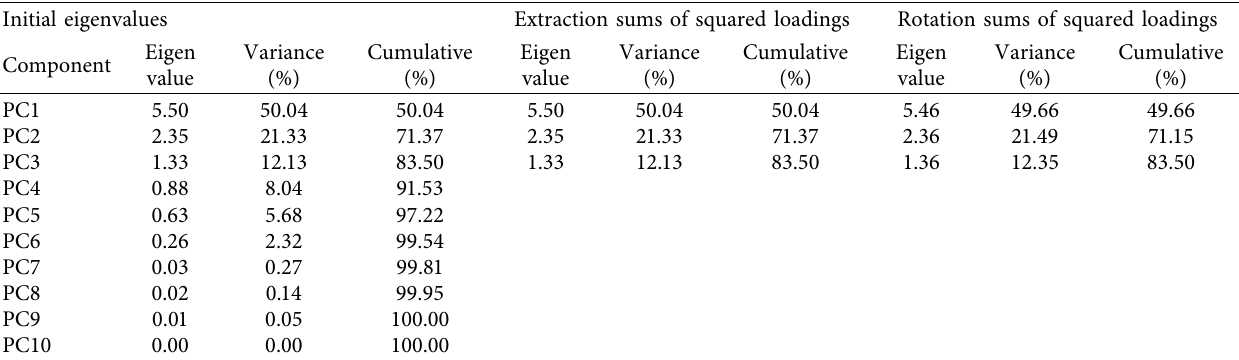
Table 6: Total variance explained (three factors selected) for heavy metals.